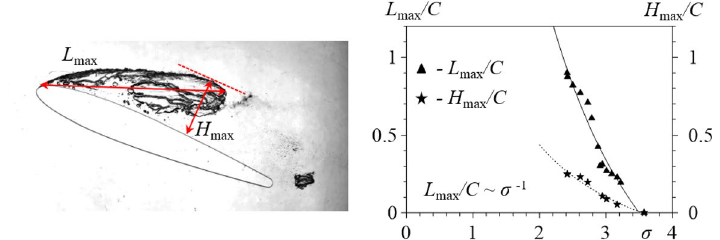
Figure 5. Characteristic attached cavitation parameters (left). Dependence of the maximum unsteady cavity length and the distance of the attached cavity from the hydrofoil on the cavitation number σ for the NACA0012 hydrofoil with the aspect ratio 0.02